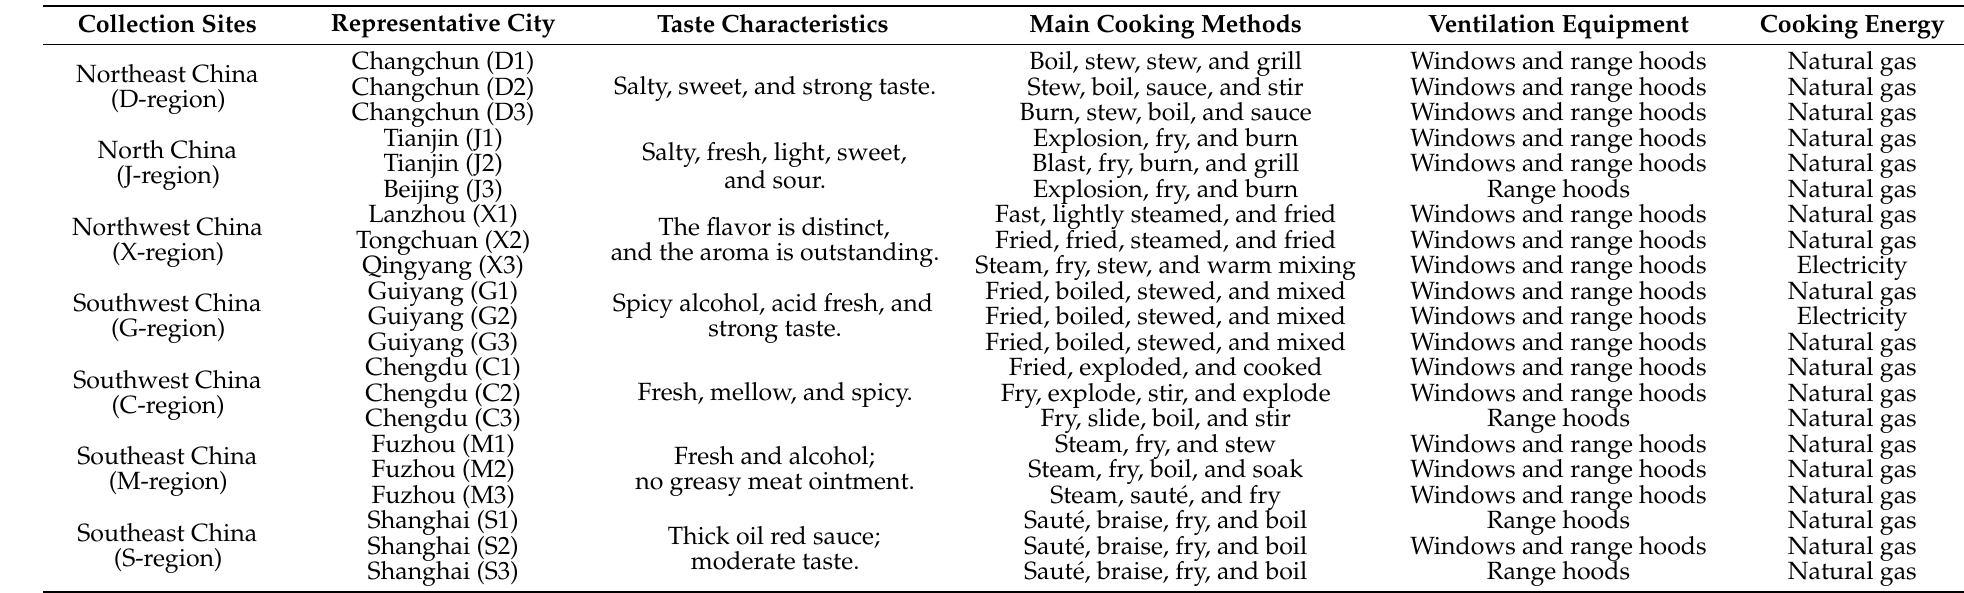
Table 1. Basic information for different sampling